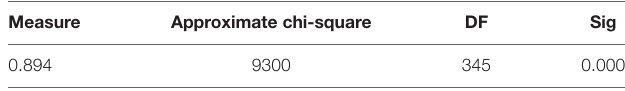
TABLE 2 | Test of statistics and